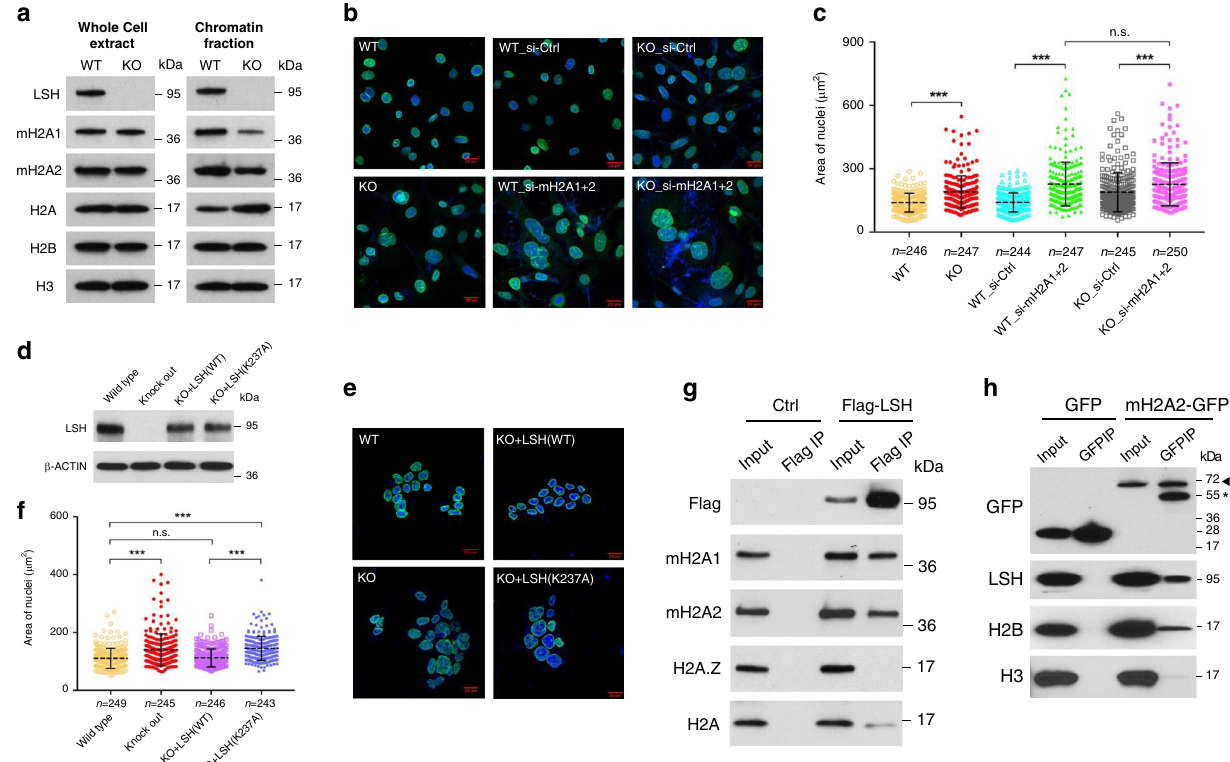
Fig. 4 LSH depletion leads to decreased chromatin association of macroH2A and to an increase of nuclear size. a Western blot analysis for detection of indicated proteins in whole-cell extract or in the chromatin fraction of Lsh WT and KO MEFs. b , c Microscopic images to visualize the nuclear size of Lsh WT and KO MEFs, or WT and KO MEFs treated with control siRNA (si-Ctrl) or two combined macroH2A siRNA (si-mH2A1 + 2) by staining with Lamin B1 and DAPI ( b ). Scale bar, 20 μ m. Quanti fi cation of nuclear area of samples as shown in c . ***adjusted p < 0.0001, n.s. means not signi fi cant. d Western blot analysis to detect restoration of LSH protein level in Lsh − / − (KO) murine ES cells after transfection with wild-type LSH (WT) or ATP mutant LSH (K 237A) vector compared to Lsh WT and KO mouse ES cells. e , f Microscopic images to visualize the nuclear size in Lsh WT and KO mouse ES cells, and KO ES cells restored with wild-type LSH (WT) or ATP mutant LSH (K 237A) by staining with Lamin B1 and DAPI ( e ). Scale bar, 20 μ m. Quanti fi cation of nuclear area of samples is shown in f . ***adjusted p < 0.0001, n.s. means not signi fi cant. g Flag-IP of indicated proteins con fi rmed by western blot analysis in U2OS cells with (Flag-LSH) or without (Ctrl) stable expression of Flag-LSH fusion protein. h GFP-IP of indicated proteins con fi rmed by western blot analysis in U2OS cells with a stably integrated vector for GFP or macroH2A2-GFP expression. An arrowhead indicates macroH2A2-GFP protein and an asterisk indicates a nonspeci fi c cross-reaction band. Data are represented as dot plots with mean ± SD ( c , f ). One-way ANOVA with Tukey ’ s multiple comparison test ( c , f ). Source data are provided as a Source Data fi